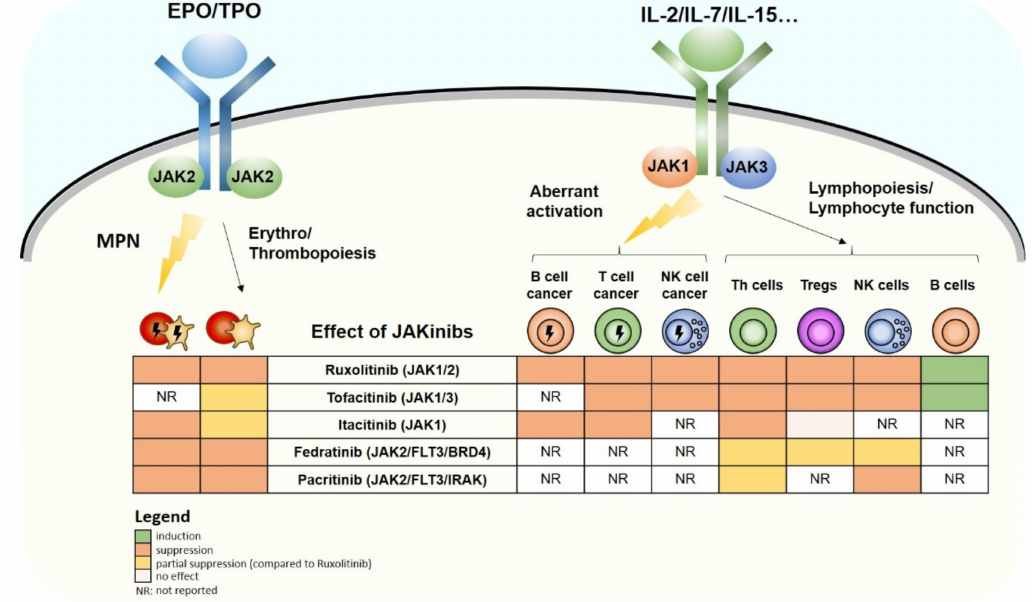
Figure 1. Schematic view of anti-tumor and immunosuppressive effects of JAKinibs downstream of JAK2/JAK2 and JAK1/JAK3-dependent pathways. Left side: In a physiological situation, EPO (erythropoietin) and TPO (thrombopoietin) signal via JAK2/JAK2 pairs to induce erythro-/thrombopoiesis (right side of the receptor). In a cancerous situation (indicated by ), the same signaling pathway drives MPNs (myelopro- liferative neoplasms; left side of the receptor). Right side: In a physiological situation, common gamma chain- dependent cytokines (e.g., IL-2/7/15) signal via JAK1/JAK3 pairs to induce lymphopoiesis and regulate T/B/NK-cell function (right side of the receptor). In a cancerous situation (indicated by ), the same signaling pathway drives leukemias and lymphomas originating from T/B/NK cells (left side of the receptor). The con- sequences of JAKinib treatment on physiological and pathological effects of the pathways are indicated by colors (see legend).